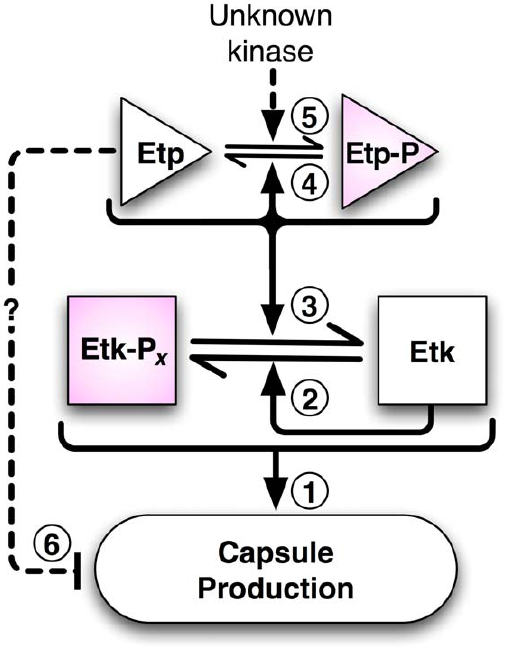
Figure 7. A model for the role of Etp and Etk in capsule formation. Cycling of Etk phosphorylation and dephosphorylation are required for capsule production (arrow 1) . This cycling is mediated by the autokinase and autophosphatase activities of Etk and Etp, respectively ( arrows 2 and 3 ). Etp also cycles between phosphorylated and unphosphorylated forms and this cycling is catalyzed by Etp autodephosphorylation (arrow 4 ) and a yet to be defined kinase (arrow 5 ). Etp cycling per se is not required for capsule formation. However, based on our results we hypothesize that the unphosphorylated Etp has an inhibitory effect on capsule formation (arrow 6 ), which can be removed by Etp phosphorylation.